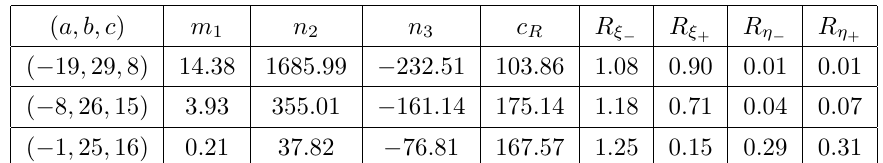
Table 5 . Values of m 1 ; n 2 and n 3 (divided by g (cid:0) 1), c geo R-charges (divided by N ) for certain triples a; b; c with negative a and (cid:20) = (cid:0) 1. Observe that the central charges and R-charges are all